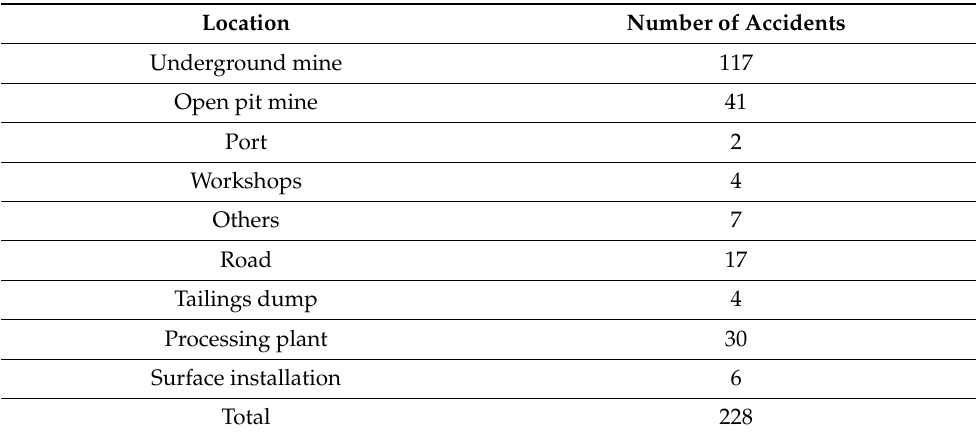
Table 2. Number of accidents resulting in death in Chile